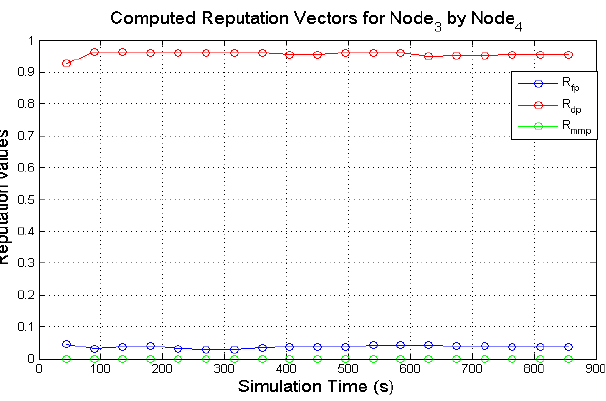
Figure 7. Reputation values for a periodically selfish node ( N 3 ) calculated by good node ( N 4 ).